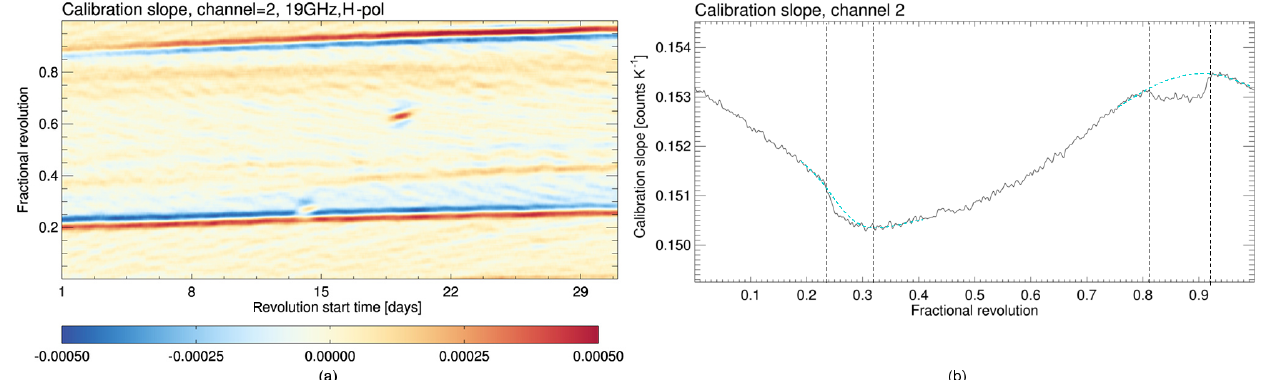
Figure 4. Edge detection results (Laplace operator) for calculated first-guess slopes from the SSM/I F13 channel at 19GHz, h-pol for Novem- ber 2005 (a ) and a cross section of the first-guess slope (b) with two sunlight intrusion events. The satellite leaves the Earth’s shadow at approximately position 0.28 and enters the Earth’s shadow at position 0.85. Positions with identified warm target anomalies are between the vertical lines. The locally fitted reconstruction splines are plotted in cyan.